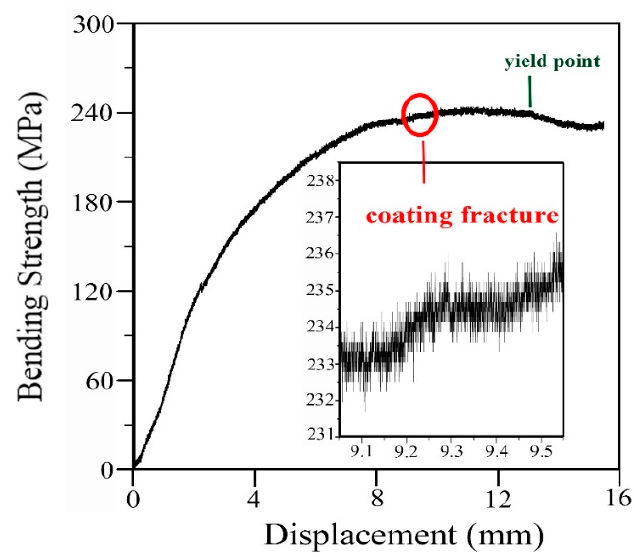
Figure 12. ( a ) Variation curves of the friction and ( b ) the sound signal with the increasing scratch load obtained via the scratch test.